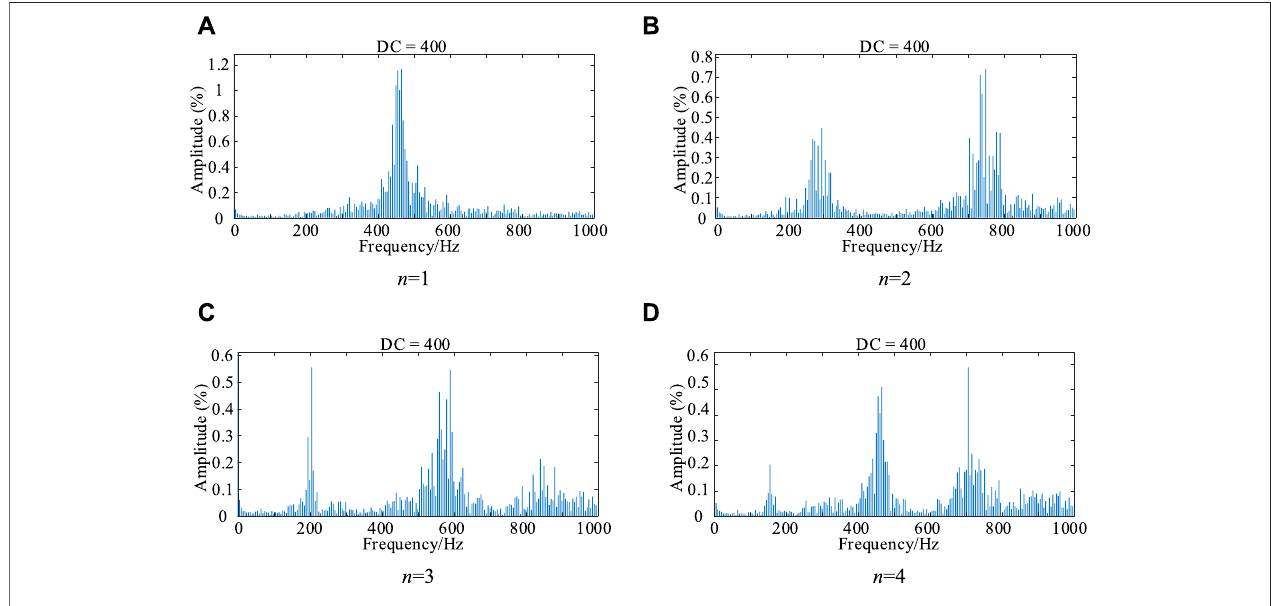
FIGURE 8 | FFT result of the input current for load zone 1 (A) n =1 (B) n =2 (C) n =3 (D) n =4.